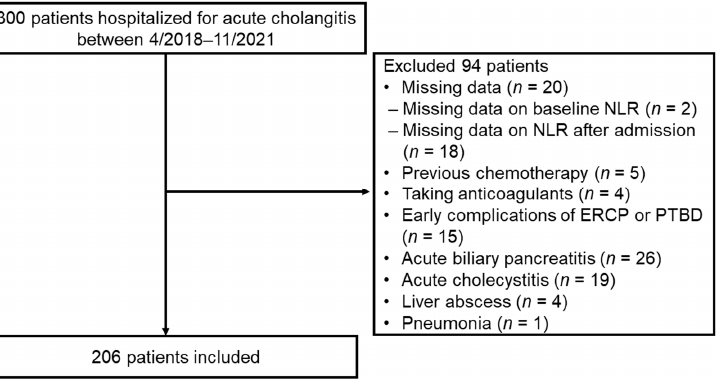
Figure 1. Flowchart of patient enrollment. NLR, neutrophil–lymphocyte ratio; ERCP, endoscopic retrograde cholangiopancreatography; PTBD, percutaneous transhepatic biliary drainage. Of the 206 acute cholangitis patients analyzed, 71 (34.5%) had mild, 107 (51.9%) had moderate, and 28 (13.6%) had severe acute cholangitis. Among the 28 patients with severe acute cholangitis, 24 had one organ/system dysfunction and 4 had two dysfunctions: he- matologic dysfunction in 12, cardiovascular dysfunction in 10, renal dysfunction in 4, he- patic dysfunction in 3, respiratory dysfunction in 2, and neurologic dysfunction in 1. Seven patients (3.3%) were transferred to the ICU, and three patients (1.4%) died within 30 days of hospitalization. The demographic and clinical features of the patients are listed in Table 1. Table 1. Demographic and clinical characteristics of 206 patients diagnosed with acute cholangitis.